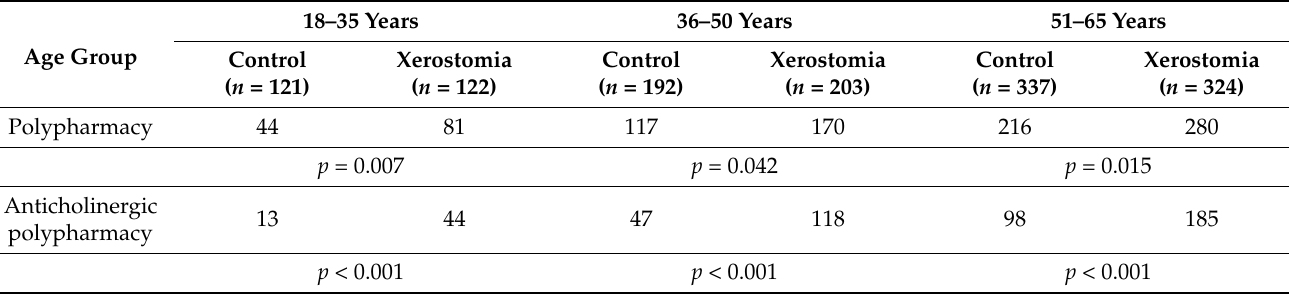
Table 3. Proportions of polypharmacy and anticholinergic polypharmacy. Comparison of observed frequencies in each age category was completed using the Chi-squared test ( p -value).